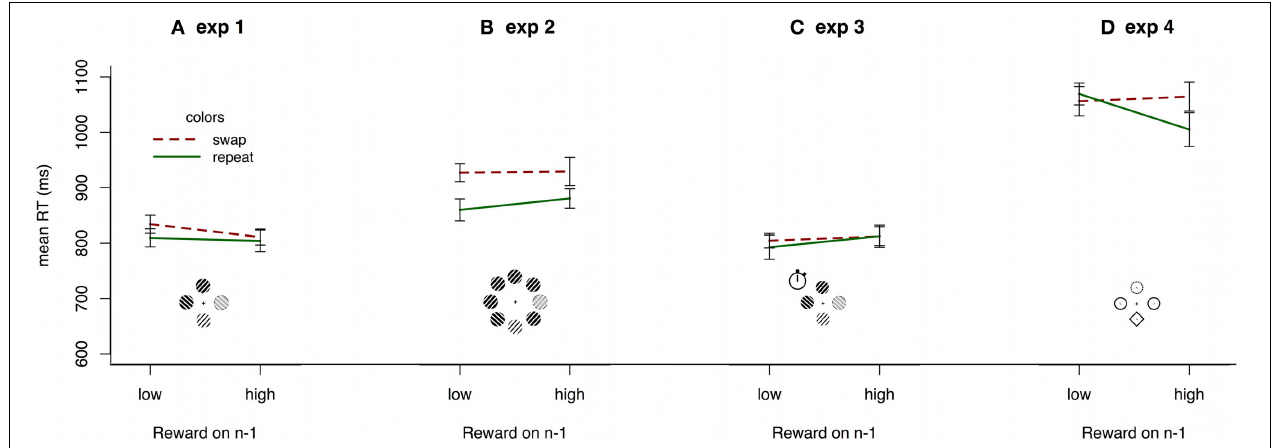
FIGURE 3 | Mean reaction times in experiments 1-4, for all observers by immediately preceding reward and repetition or switch of the color scheme from the preceding trial. Search arrays show stimuli and